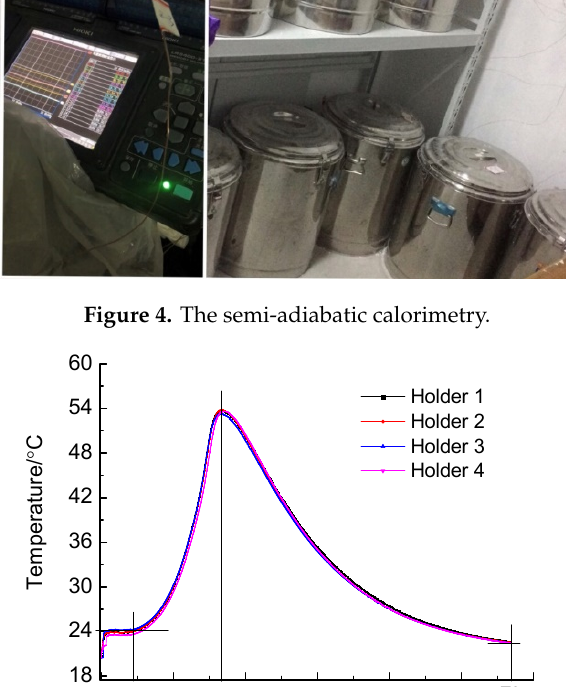
Figure 5. The consistency of the testing results for the blank sample in different insulative holders.